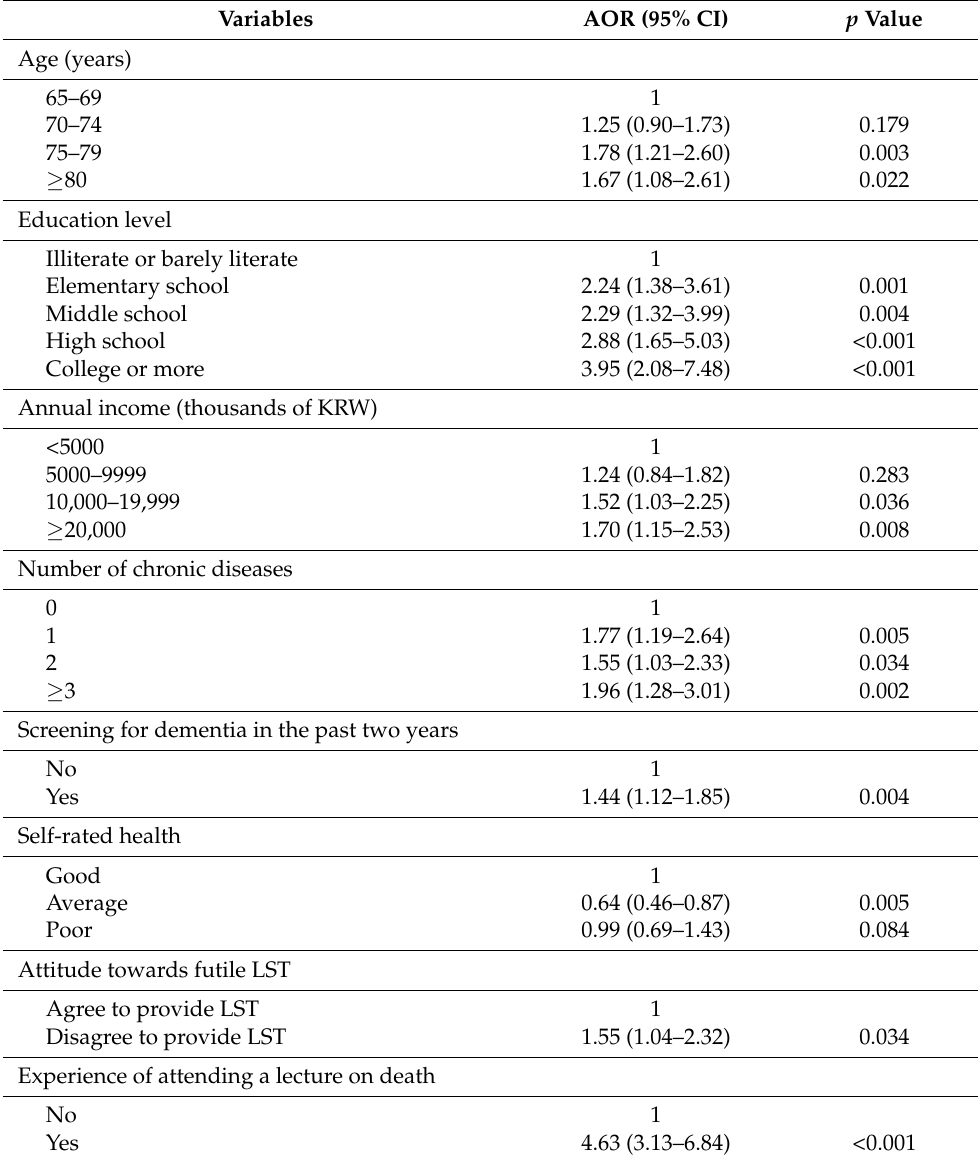
Table 3. Multivariable logistic regression analysis of factors associated with the presence of advance directives among older adults ( n =